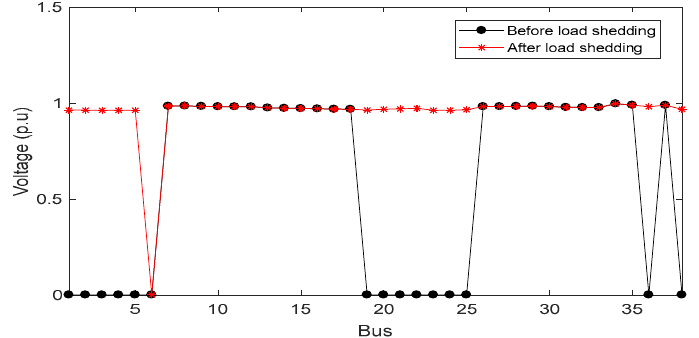
Figure 10. Bus voltages at faulted bus #6 prior to and after load